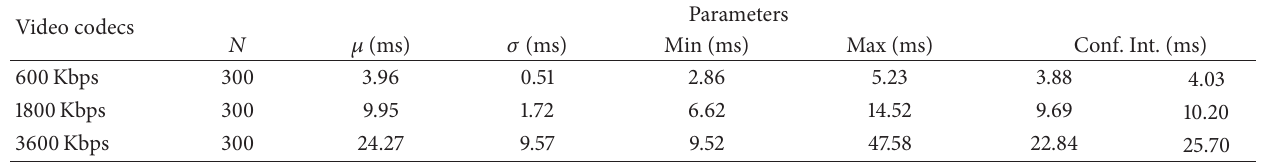
Table 2: Statistical values of the delay of different streams using different codecs.